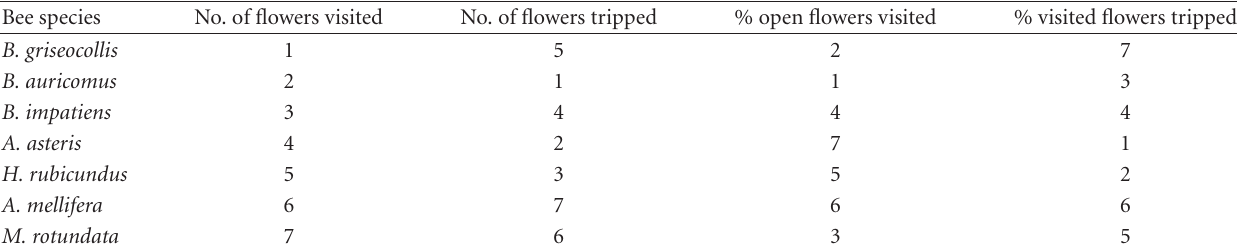
Table 2: The relative rank of Bee species with respect to the number of flowers visited per raceme; the number of flowers tripped per raceme; the proportion of open flowers that were visited per raceme and the proportion of visited flowers that were tripped per